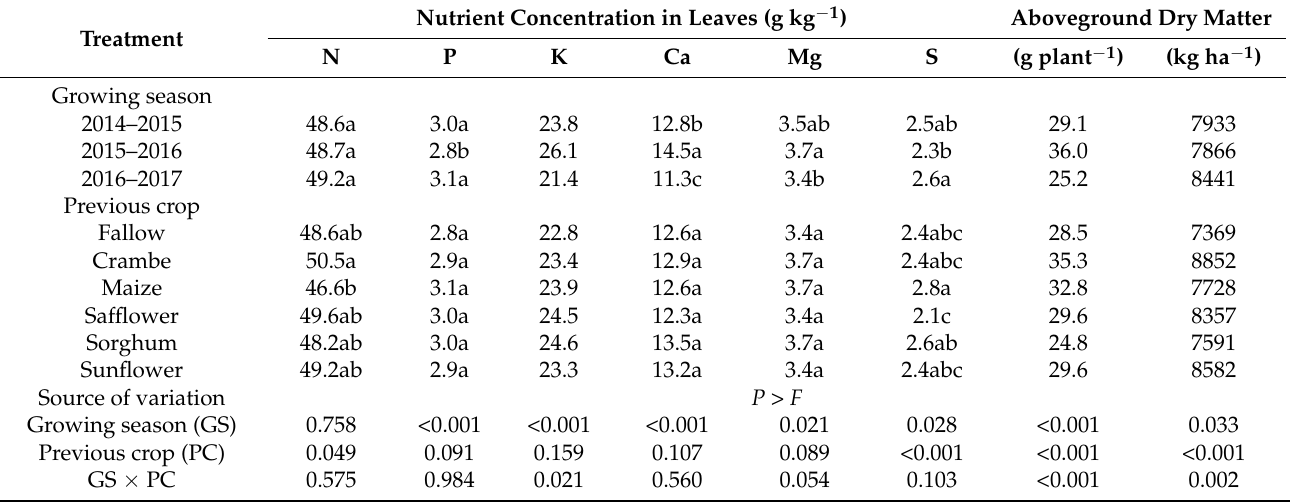
Table 2. Leaf nutrient concentrations and aboveground dry matter of spring–summer soybean crop following different fall–winter crops in three growing season, and analyses of variance.